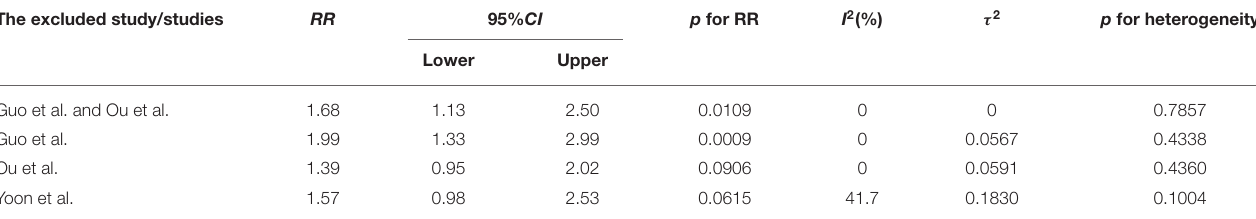
TABLE 5 | The pooled estimate and heterogeneity by excluding the specific study from the whole collection in the comparison of conduction abnormalities between type 1 and type 0 BAV morphology. The excluded study/studies RR 95% CI p for RR I 2 (%) τ 2 p for heterogeneity Lower